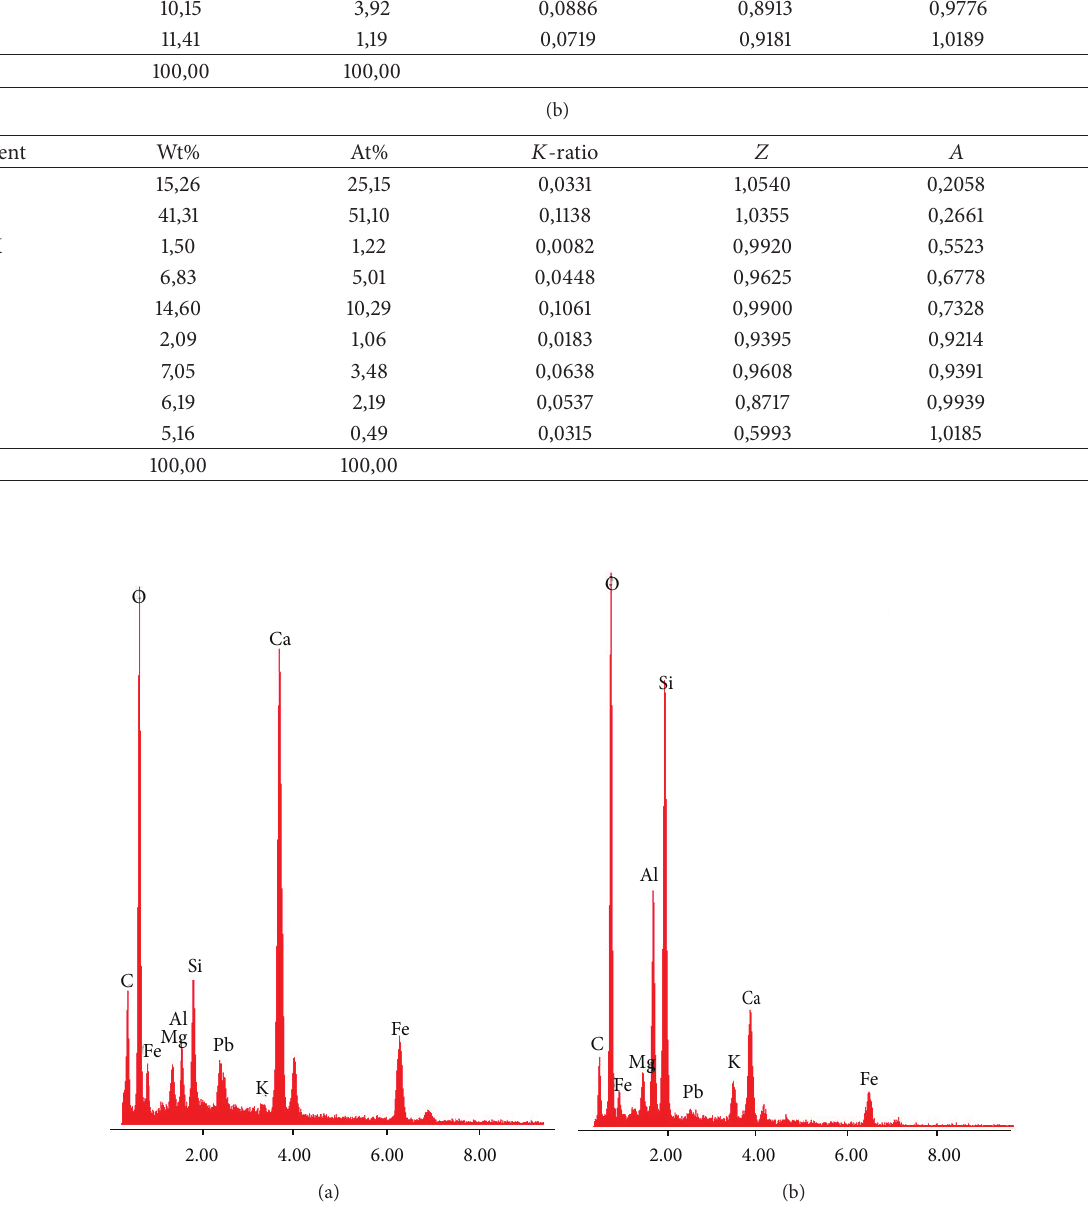
Figure 5: EDAX spectra from VI59B7Z sample taken on the surface (a) and cross section